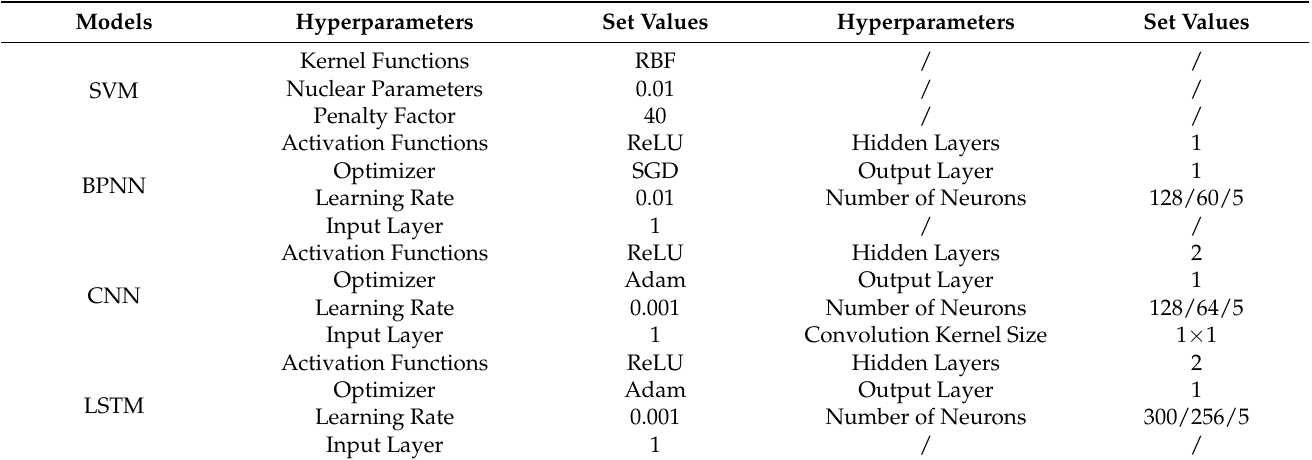
Table 3. The optimal parameters of different prediction